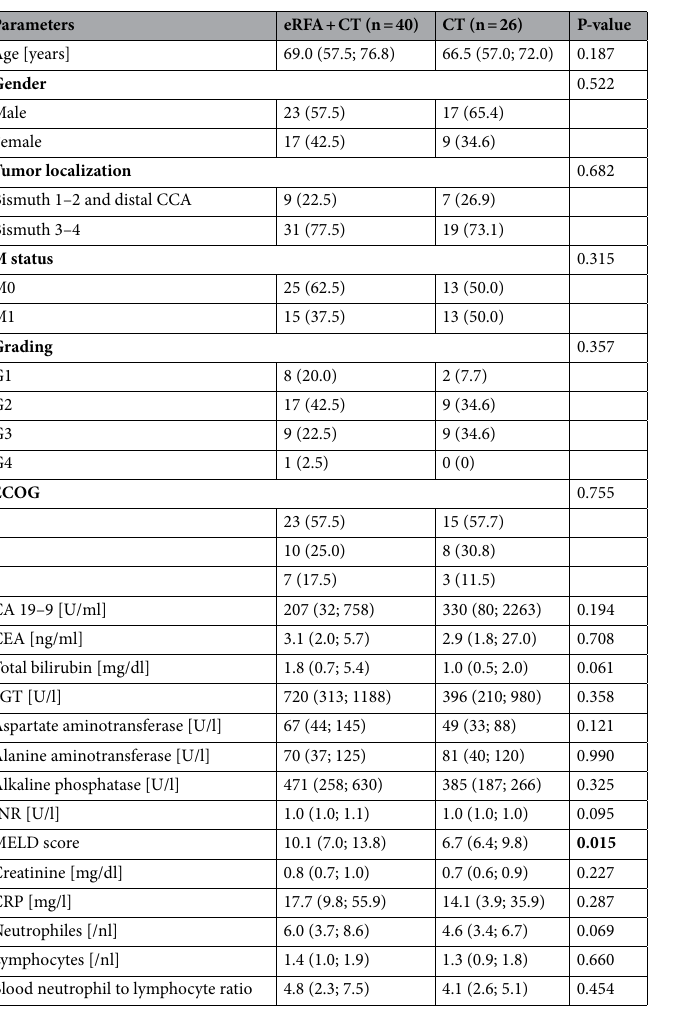
Table 1. Baseline characteristics. Categorical data are presented as absolute frequency with relative frequency in parentheses. Numerical data are presented as median with under and upper quartile in parentheses. P values of categorical data refer to Chi-squared test or Fisher exact test between groups eRFA + CT and CT. P values of numerical data refer to Student unpaired t test or Mann–Whitney test between groups eRFA + CT and